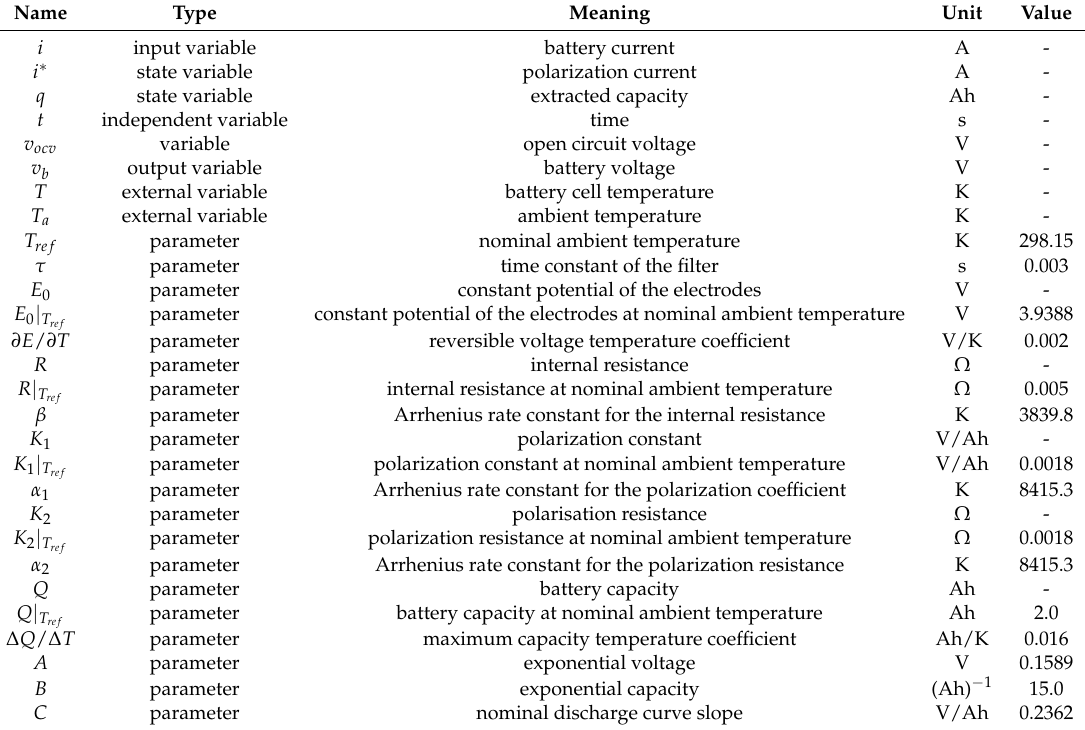
Table 1. Variables and parameters of the examined Samsung INR18650-20Q Li-ion